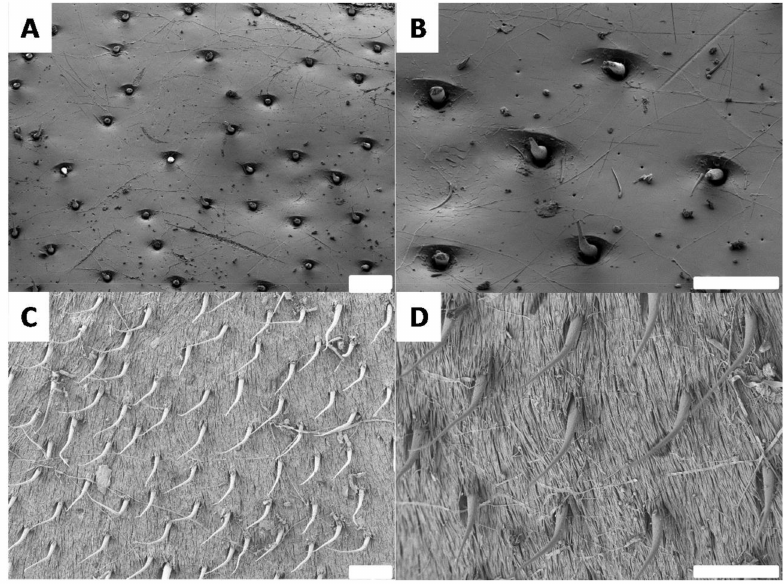
Figure 8. Scanning electron microscopy images showing the morphology of the G. orientalis ( A , B ) black and ( C , D ) white surfaces. Scale bar: 100 µ